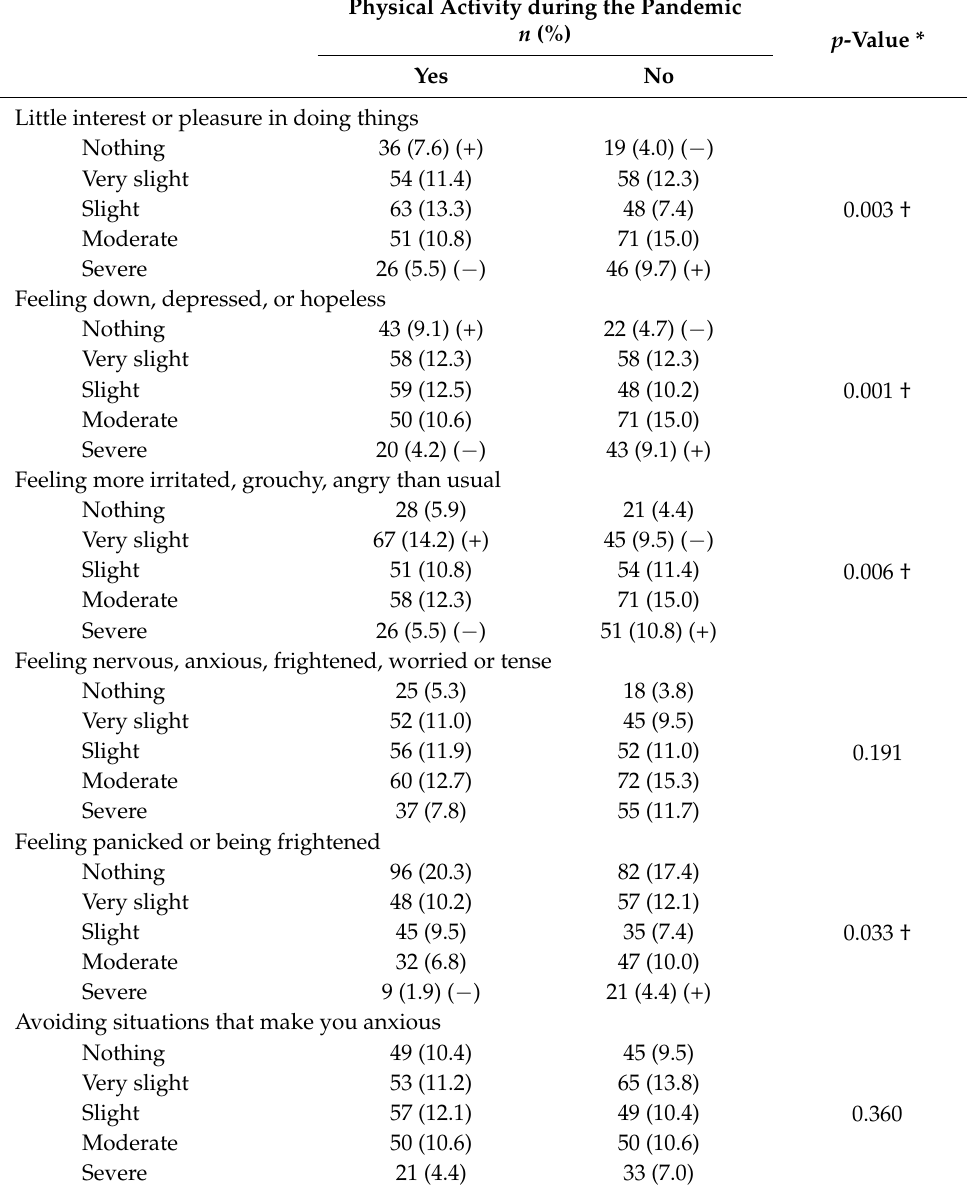
Table 1. Association between physical activity and mental health in individuals with type 1 Diabetes Mellitus during social isolation in Brazil, 2020. Physical Activity during the Pandemic n (%) p -Value